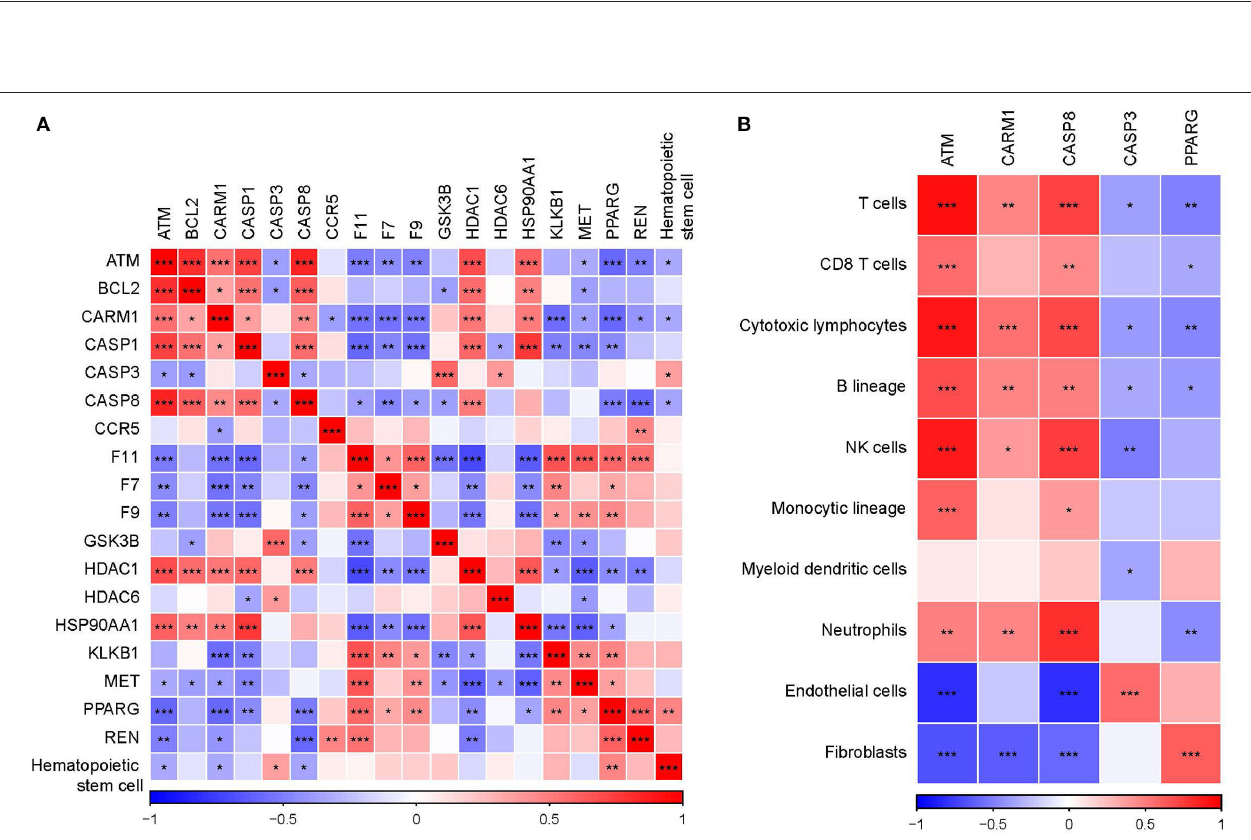
Frontiers in Public Health |